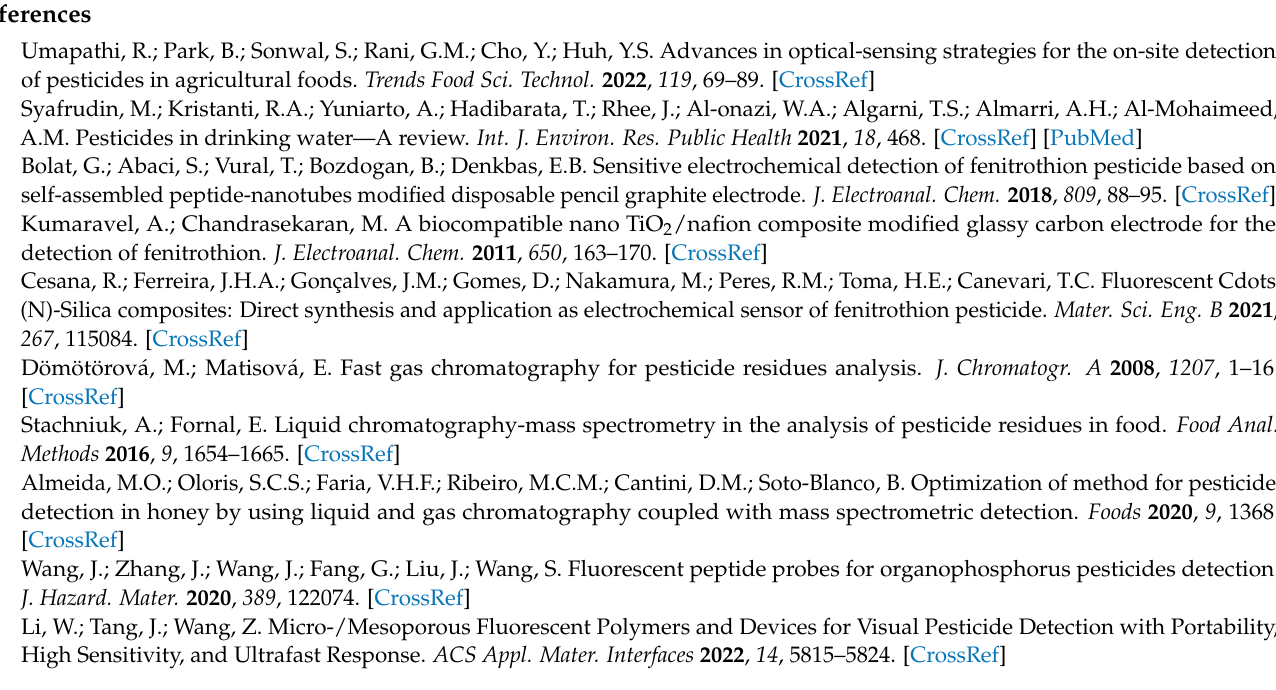
methods: (black line) the first 2 CV curve with potential from 0.6 to − 1.0 V and scan rate of 50 mV/s; (red line) the third-step DPV curve with potential increment of 13 mV, amplitude of 50 mV, pulse width of 60 ms, sampling width of 20 ms, pulse period of 500 ms and potential from 0.6 to − 0.9 V; Figure S5: the third-step DPV curves of different electrodes in blank (no FNT) acetate buffer solution (pH = 5.00), DPV parameters: potential increment of 13 mV, amplitude of 50 mV, pulse width of 60 ms, sampling width of 20 ms, pulse period of 500 ms and potential from 0.6 to − 0.9 V; Figure S6: the variation of I pc,2 with the accumulation time of every step of DPV method: (a) the first step; (b) the second step; (c) the third step; Figure S7: (a) the variation of I pc,2 with potential increment; (b) the variation of I pc,2 with amplitude.; Figure S8: (a) The I pc,2 of seven proposed sensors prepared in the same manner; (b) the variation of I pc,2 with different interfering